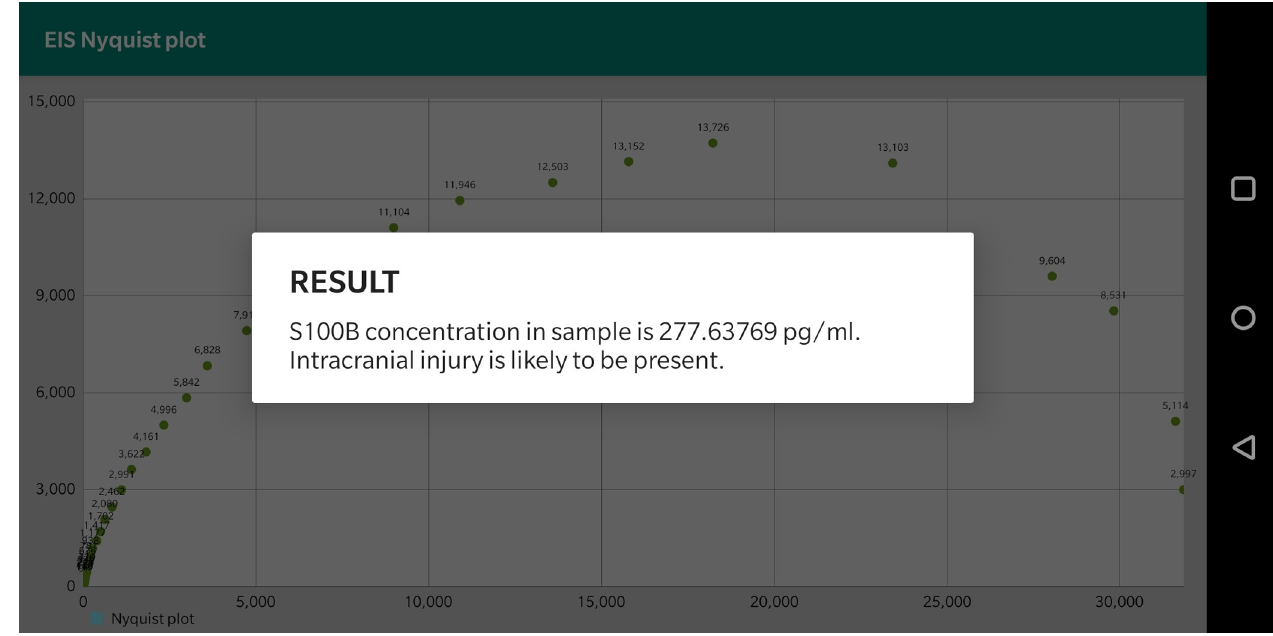
Fig 12. Brain injury support information after the EIS